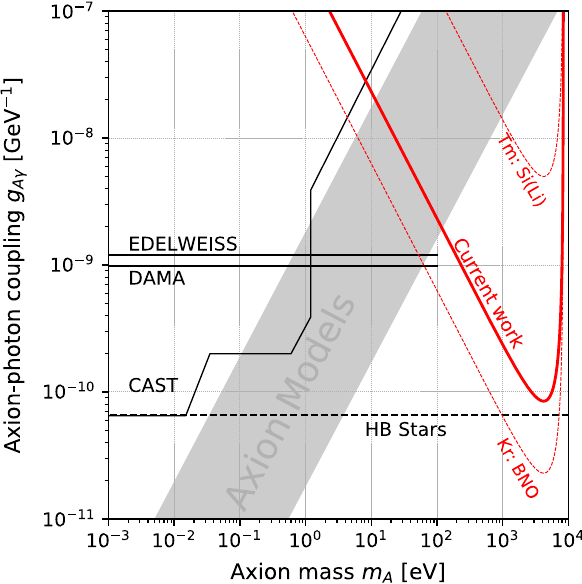
Fig. 4 Axion–photon coupling g A γ limits obtained in current work in comparison with other experiments (DAMA [39], EDELWEISS [40], CAST [41], 169 Tm-Si(Li) [15], 83 Kr-gas counter [18]) and astrophysi- cal bounds (horizontal branch stars lifetime [42])